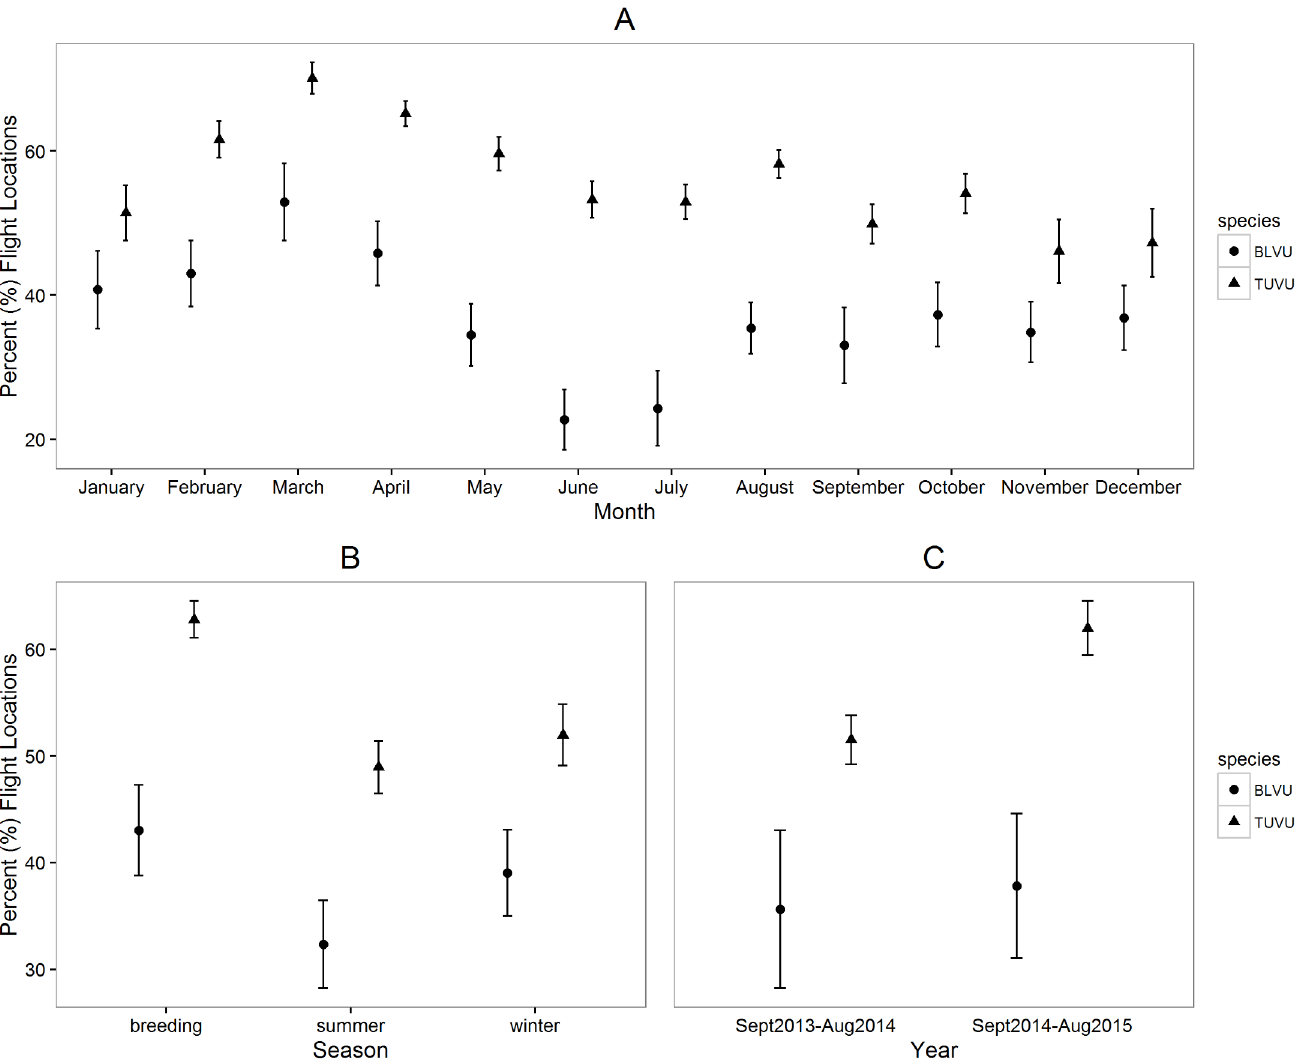
Fig 3. Mean ( ± 95% CIs) percentageof locationscharacterized as “in flight” by (A) month, (B) season, and (C) year for 9 black vultures (BLVU; total locations= 990,289; mean = 110,032; range = 29,808–171,932) and 9 turkey vultures (TUVU; total locations= 1,595,225; mean = 177,247; range = 38,694–241,187)calculatedfrom GPS locationscollectedSeptember 1, 2013–August 31, 2015.